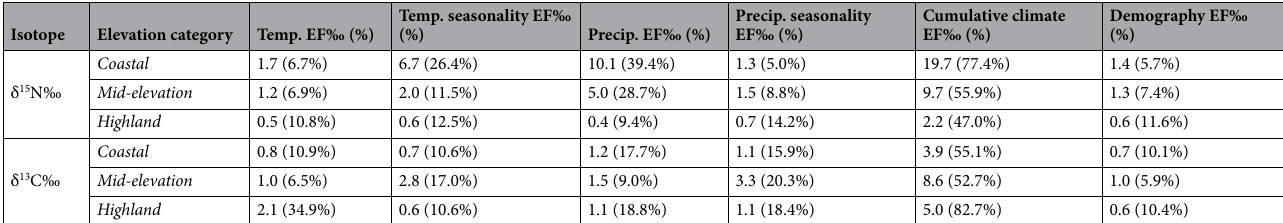
Table 2. Random forest model effect sizes with corrected KDEs. Model sum of squares effect sizes (amount of variation in δ 15 N‰ or δ 13 C‰ explained) for each variable within the elevation categories. These values are in per mil (‰). Percentages are the model sum of squares effect sizes as a percent of the total amount of variation. Effect sizes are directly comparable within each isotope, but not between them, given that there are different models for each stable isotope. Values here have been deducted by Friedman’s H -statistic to remove the proportion of the effects resulting from interaction between variables. Here demography is generated via taphonomically corrected KDEs. Note: the effect sizes are calculated through iterated simulation employing representative subsets of each key predictor variable, as they do not include every possible combination the percentages will not sum to 100 .